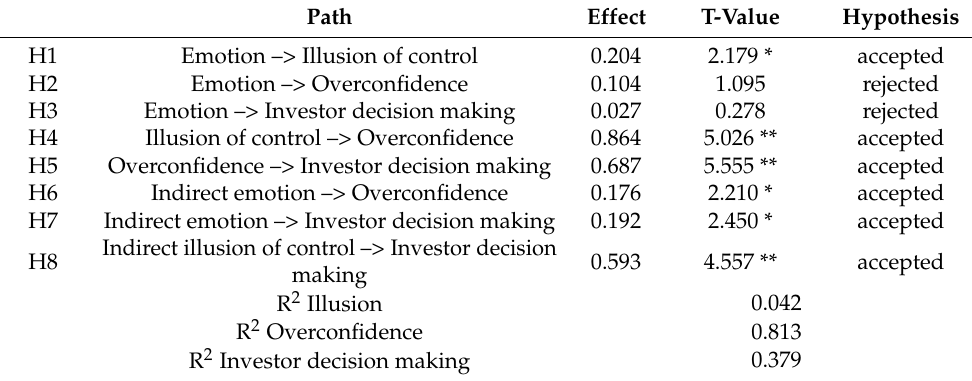
Table 5. Summary of Path